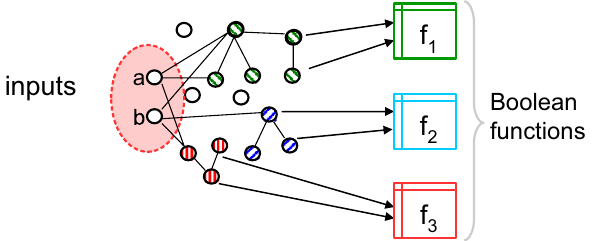
Figure 2. LTM nodes compute Boolean functions in computational cascades . Iterating through all possible perturbations of input seed nodes a and b , each non-seed network node must compute some Boolean function on the inputs.